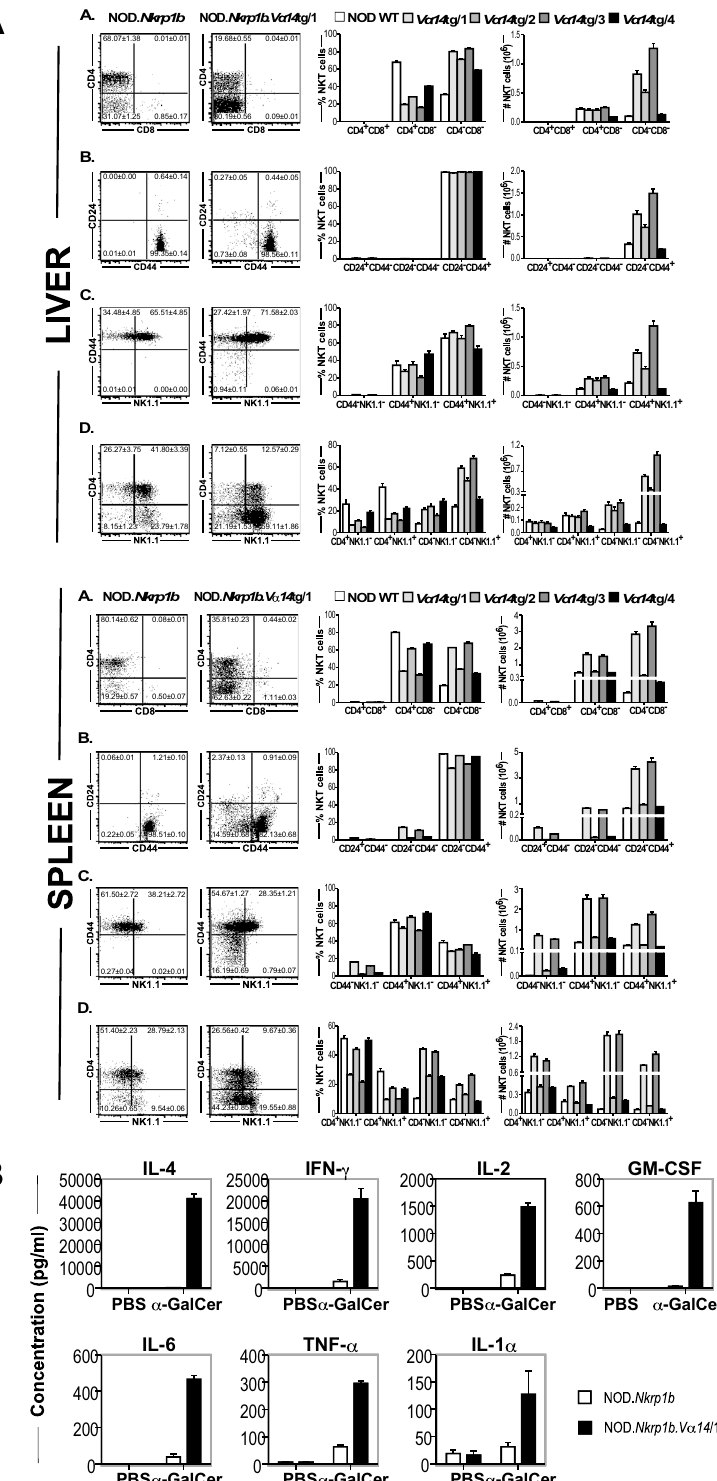
Figure 3. Comparison of hepatic and splenic NKT cell subsets and cytokine production in WT and NOD. Va14 tg mice. A) Representative FACS plots (left panel) show the mean frequencies (± SEM) of NKT cell subsets in total hepatic (Top panels) or splenic (Bottom panels) NKT cells of NOD WT and NOD. Va14 tg mice. ( A ) CD4/CD8 NKT cell subsets. ( B ) CD24/CD44 NKT cell subsets. ( C ) CD44/NK1.1 NKT cell subsets. ( D ) CD4/NK1.1 NKT cell subsets. Histograms (right panel) show the mean frequencies and absolute numbers of hepatic or splenic NKT cell subsets between NOD WT (clear bars) and the four NOD. Va14 tg mouse lines (filled bars). (n = 10 female mice/group. Data are combined from two independent experiments). ( B ) The effect of i.v. α-GalCer administration on cytokine production in NOD. Va14 tg mice shows that Vα14 transgenic expression increased cytokine production. Histograms show the mean concentration (± SEM) of IL-4, IFN-γ, IL-6, IL-2, GM-CSF, TNF and IL-1 in serum of NOD WT mice (clear bars) and NOD.Va14Tg/1 mice (filled bars), 4 h after challenge with α-GalCer (n = 6–10